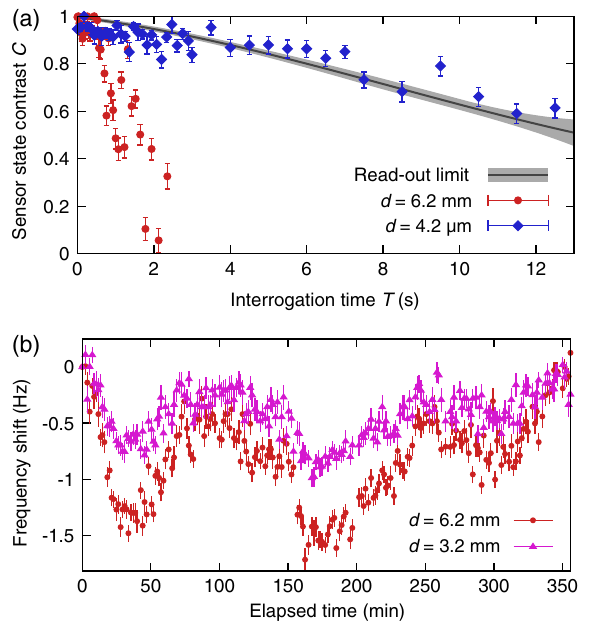
FIG. 3. (a) Sensor state contrast C versus interrogation time T at the maximum ion distance of d ¼ 6 . 2 mm (red dots) and at an ion distance of d ¼ 4 . 2 μ m (blue squares). For illustration, the black curve and gray region indicate a third-order polynomial fit to a separate read-out fidelity measurement and its confidence bands. (b) Simultaneous drift of the measured frequency difference for ion distances d ¼ 6 . 2 mm (blue circles) and d ¼ 3 . 2 mm (purple triangles) over a duration of about 6 hours with an interrogation time of T ¼ 150 ms. For d ¼ 3 . 2 mm, the measured drift is suppressed by a factor of about 1.6 as compared to the maximum ion